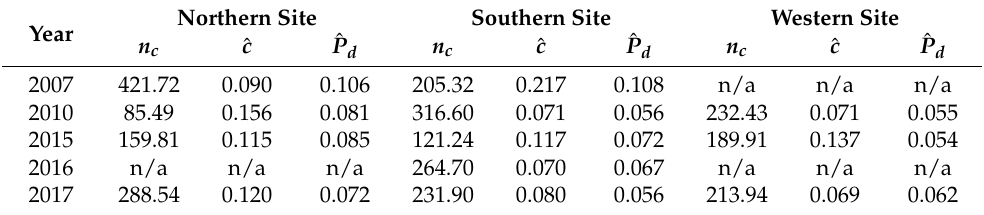
Table 3. Average number of detected clicks in 45 min ( n c ), false positive rate (ˆ c ) and probability of detection ( ˆ P d ) at three sites for each survey year.